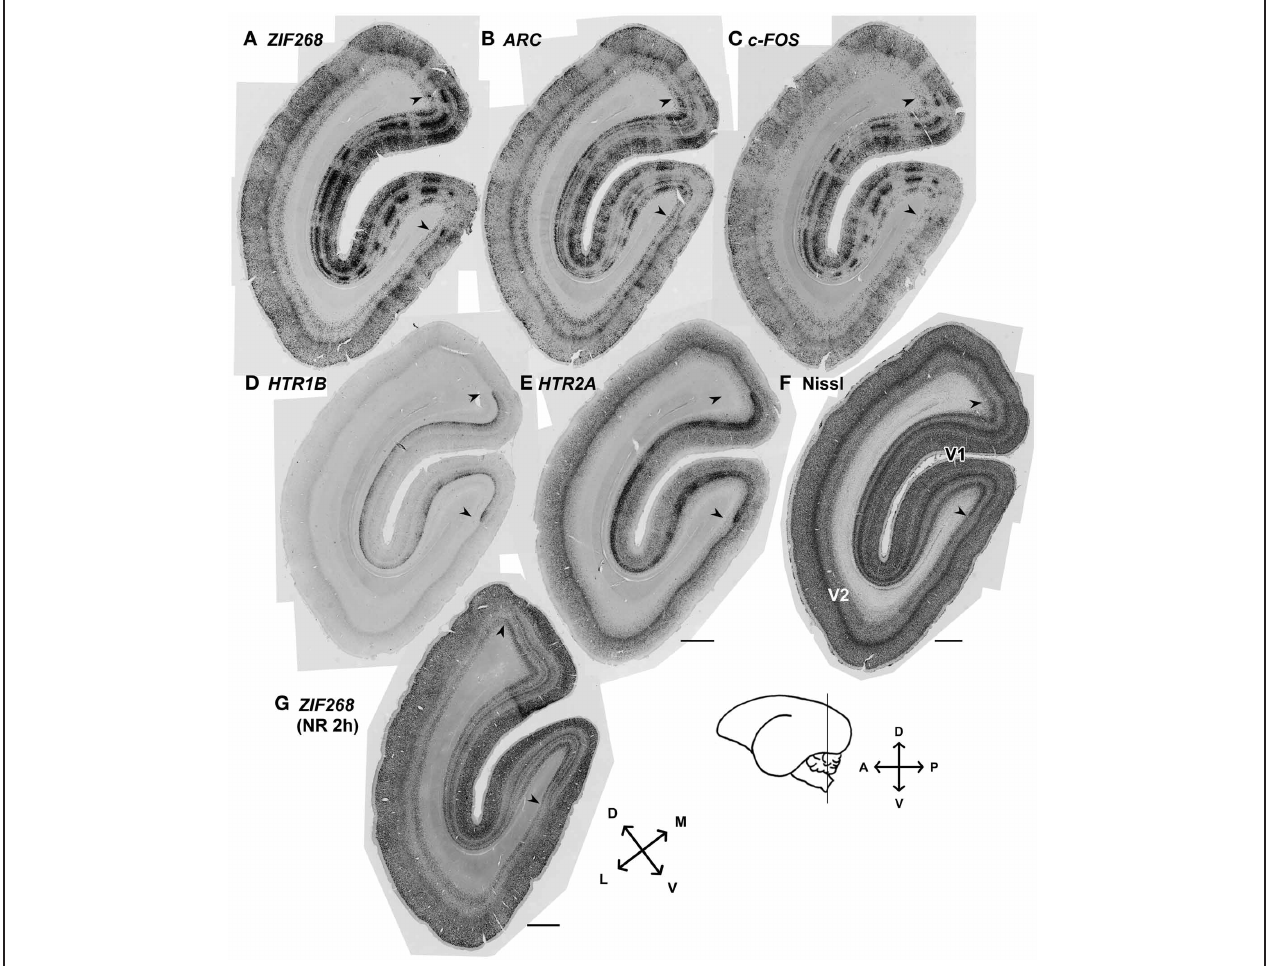
FIGURE 2 | mRNA expression patterns of five activity-dependent genes induced by monocular light stimulation in visual cortices of adult marmosets. (A–E) mRNA expression patterns for activity-dependent genes we examined in the visual cortex 24min after light stimulation: (A) ZIF268 , (B) ARC , (C) c-FOS , (D) HTR1B , and (E) HTR2A . Columnar patterns within V1 indicate ocular dominance columns. (F) Cortical section stained for Nissl substance. Adjacent sections were analyzed in (A–F) . Magnified images at